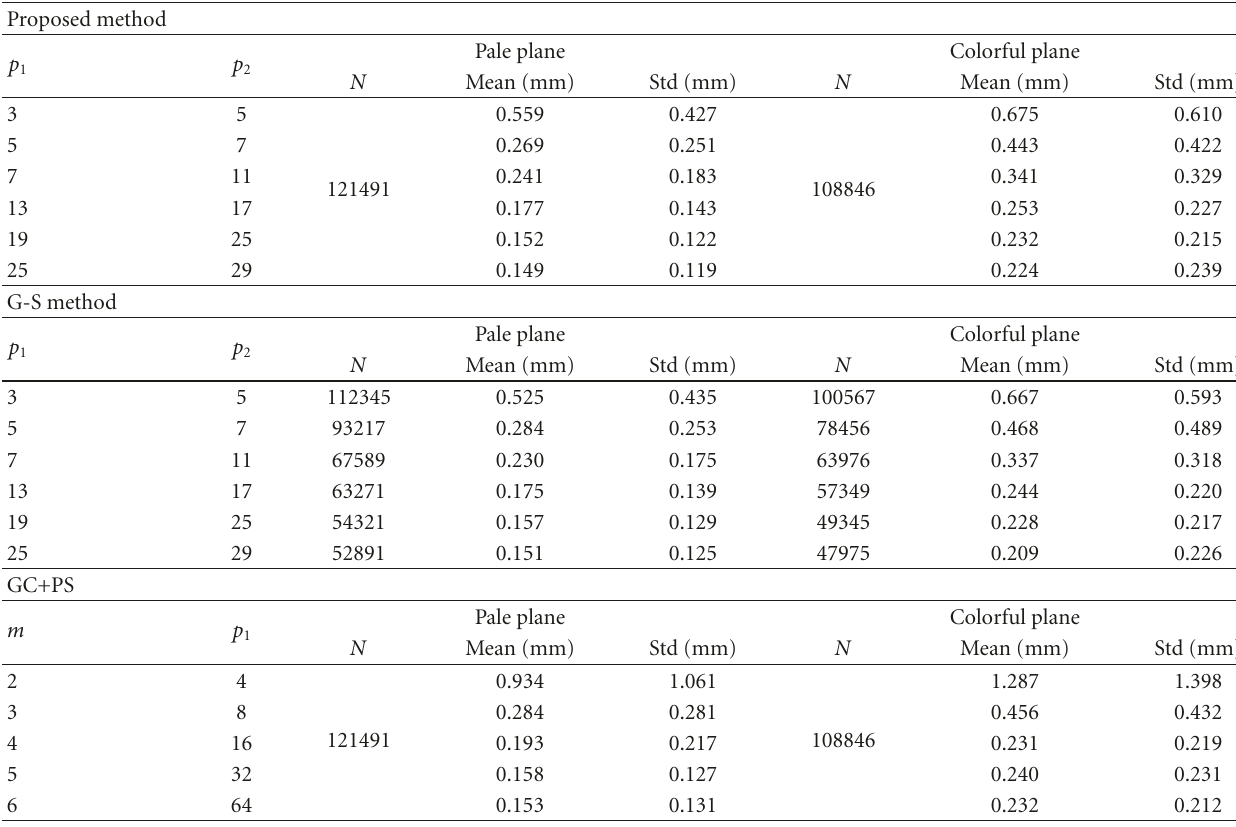
Table 1: Mean error and standard deviations of distances for total of N reconstructed points with respect to the fitted plane through those N points. p 1 and p 2 show the chosen number of periods for periodic patterns used to construct wrapped PS maps. m is the Gray code word length.